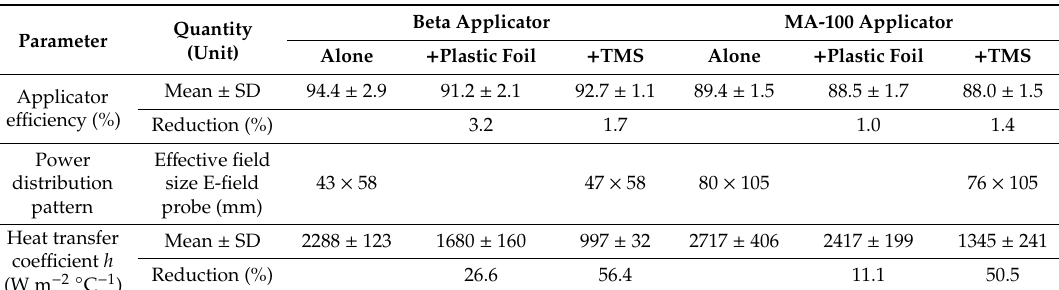
Table 3. Results of the phantom experiments for applicator e ffi ciency, power distribution pattern (e ff ective field size), and of the heat transfer of the water bolus. Results are presented for the applicators alone, applicators with a 10 µ m high density polyethylene plastic foil, or applicators with the thermal monitoring sheet (TMS) positioned between the water bolus and the